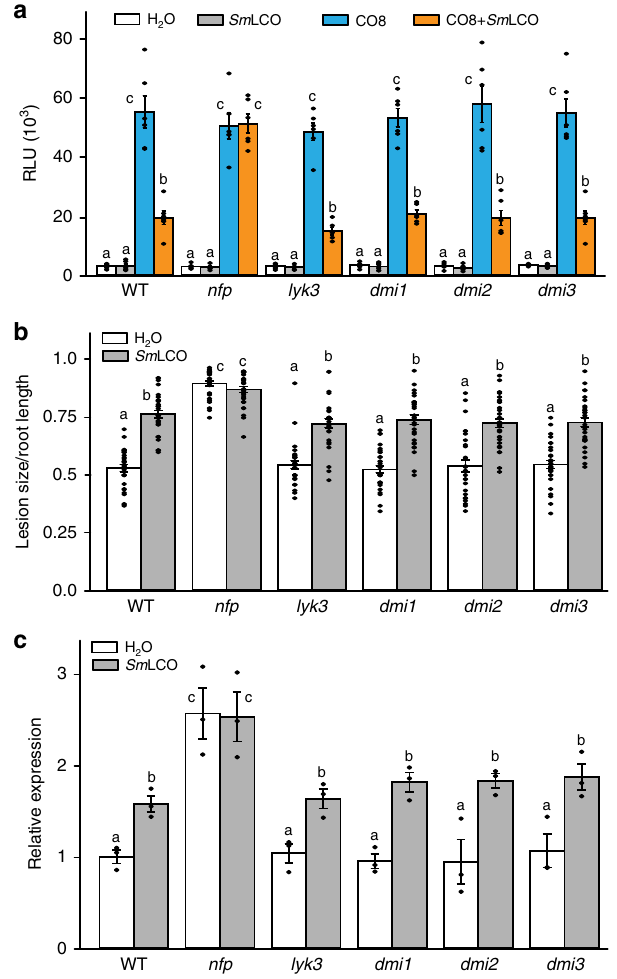
Fig. 6 NFP but not other symbiosis signalling components are required for LCO suppression of plant immunity. a M. truncatula wild-type and mutant roots were pre-treated with 10 − 8 M Sm LCO for 30 min before challenging with CO8 for ROS induction. This experiment was repeated three times with similar results. b M. truncatula roots with or without Sm LCO treatments were inoculated with P. palmivora and the lesion size quanti fi ed relative to root length or c quantity of pathogen measured using ampli fi cation of P. palmivora EF1a relative to M. truncatula H2A . These experiments were repeated twice with similar results. Letters denote statistically signi fi cant groupings calculated with Mann-Whitney Rank Sum Test (mean ± s.e.m., n = 6 for a , n = 30 for b and n = 3 for c , P <